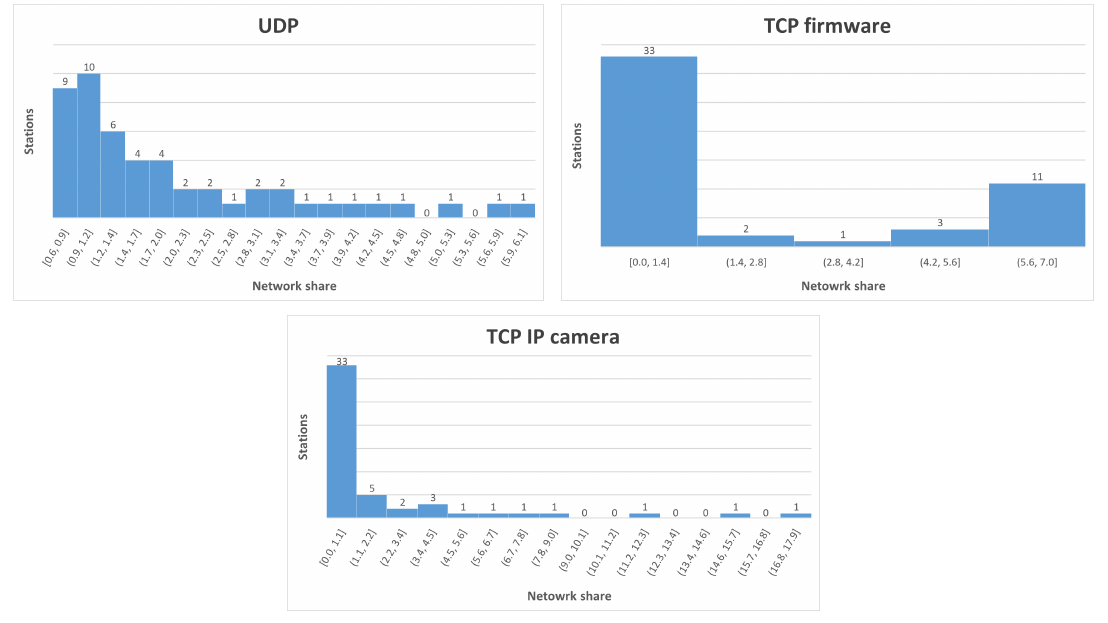
Figure 8. Network share distribution in 60 s for 50 stations divided into two RAW